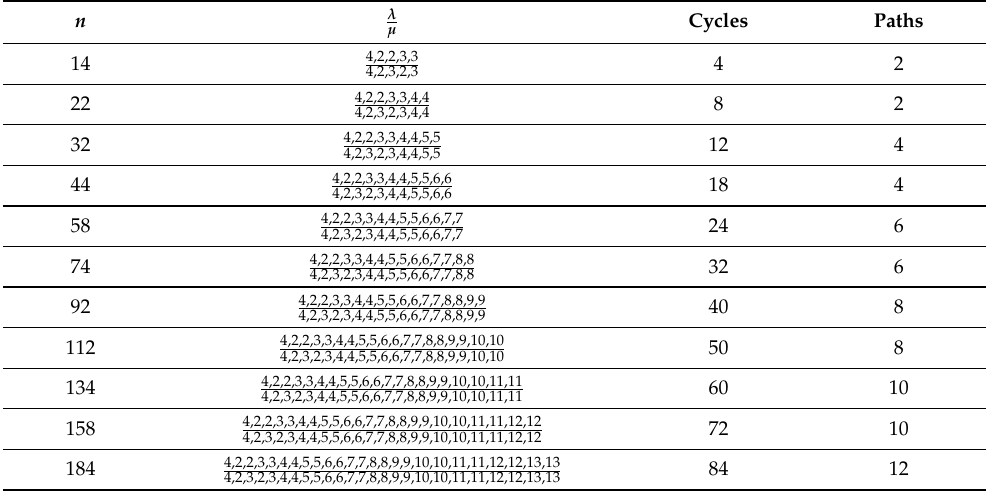
Table A1. Number of cycles and paths in the meander induced by compositions of type T 0 of n .